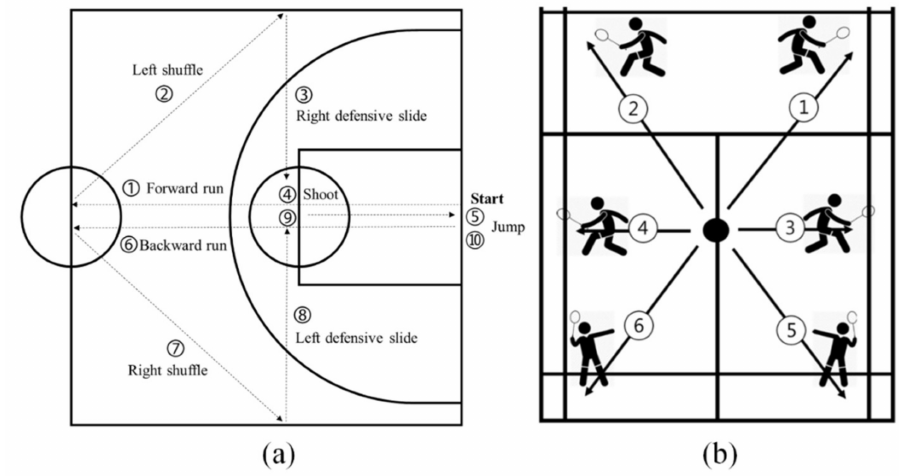
Figure 2. Custom basketball exercise routine ( a ) and badminton six-point footwork ( b